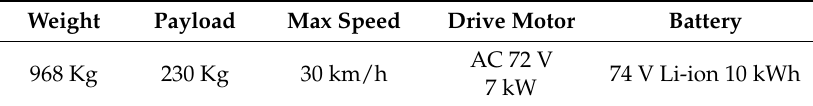
Figure 7. Agricultural utility vehicle used for actual driving experiment. Table 3. Specifications of the agricultural utility vehicle.